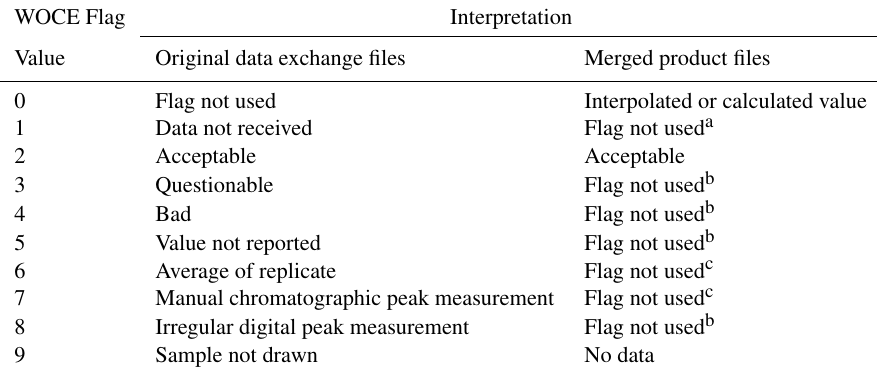
Table 2. WOCE flags in GLODAPv2.2021 exchange-format original data files (briefly; for full details see Swift, 2010) and the simplified scheme used in the merged product files.